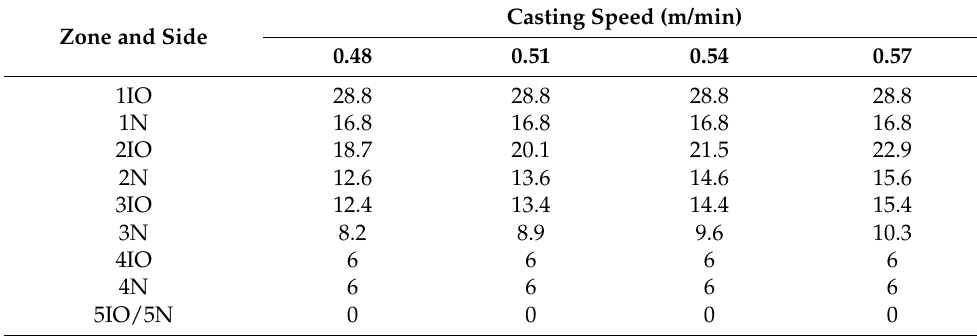
Table 6. Water table for GCr15 before optimization.